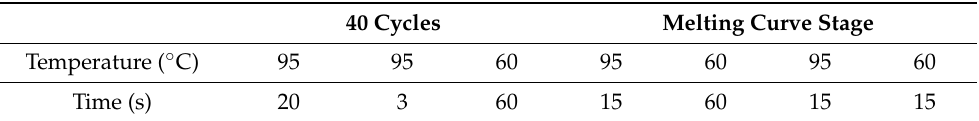
Table 2. qPCR protocol for the Applied Biosystems 7500 Fast Real-Time PCR System. PCR prod- uct amplification was achieved through 40 cycles, followed by a melting curve stage to ensure reaction